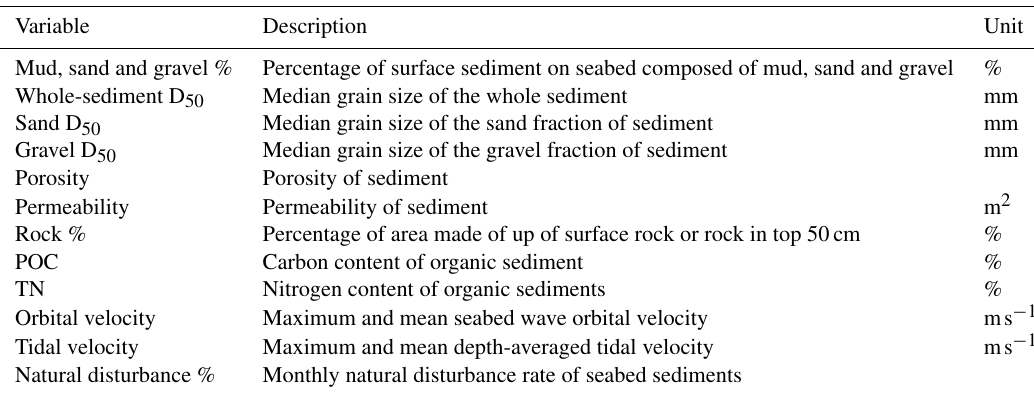
Table 1. Data products created at a spatial resolution of 0.125 ◦ by 0.125 ◦ .